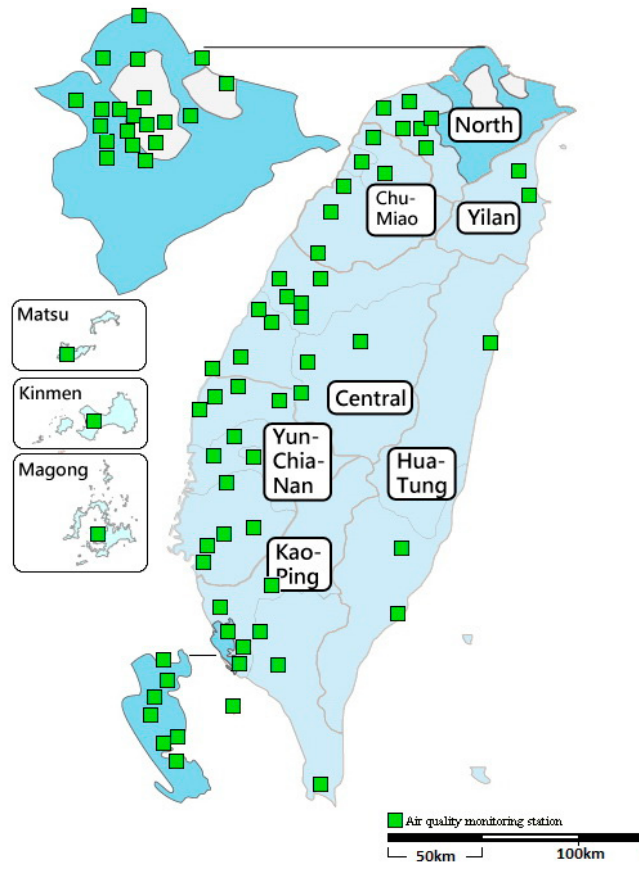
Figure 1. The seven air quality regions and an outlying islands region of Taiwan.